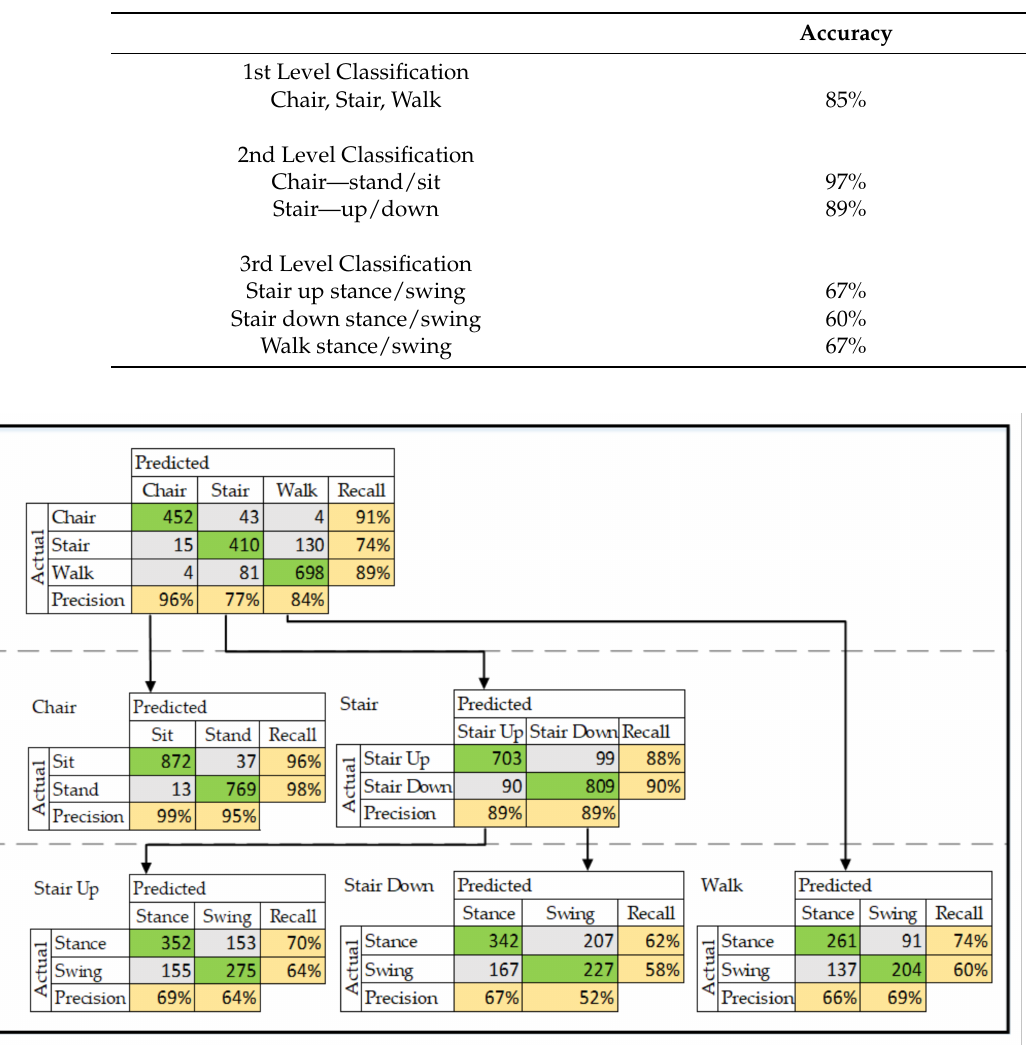
Figure 6. Confusion matrices for classification of activities/phases per classification level. Green cells represent correct classification and arrows represent the classification pathway from activities to phases of